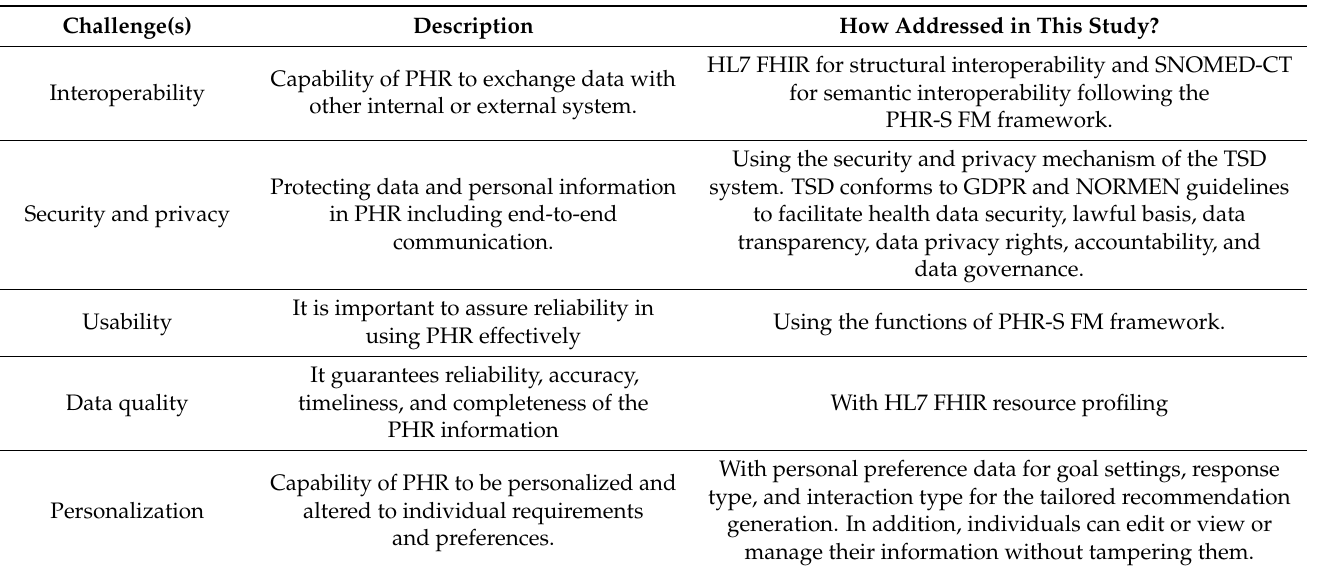
Table 6. The addressed challenges in the implementation of the PHR